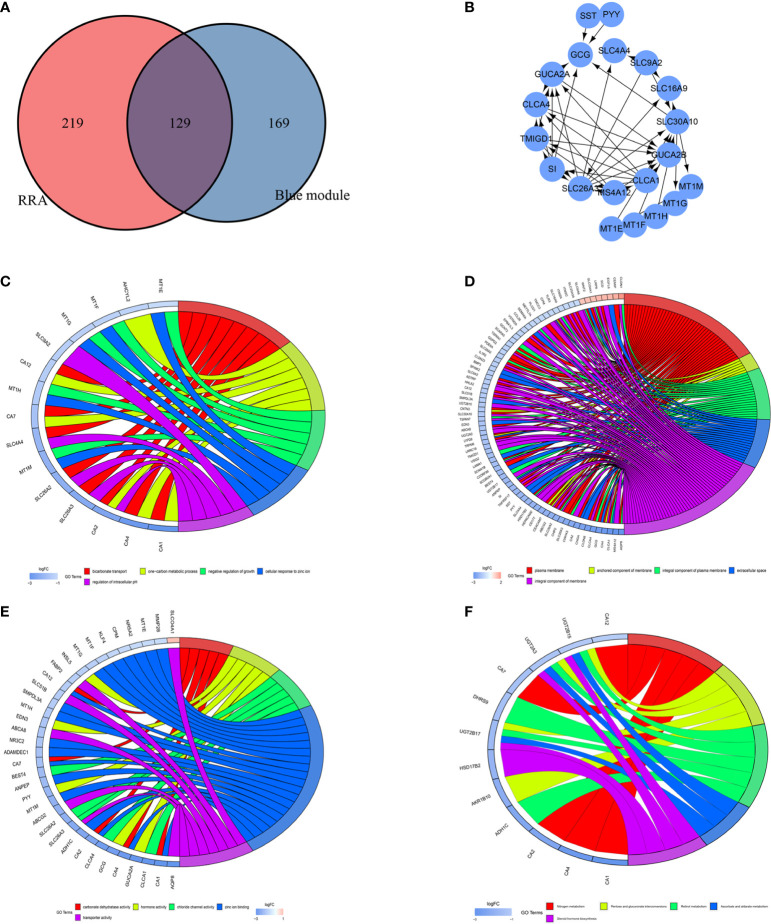
Identification of differentially expressed genes (DEGs) and hub genes. Gene ontology (GO) and Kyoto Encyclopedia of Genes and Genomes (KEGG) analyses of the DEGs. (A) Venn diagram showing the numbers of DEGs. Red indicates blue module genes in Weighted Gene Co-Expression Network Analysis (WGCNA) from the TCGA-COAD and TCGA-READ datasets. Blue indicates significantly differentially expressed genes in robust rank aggregation (RRA) analysis of Gene Expression Omnibus (GEO) datasets. (B) PPI network of 20 hub genes. (C) Chord plot depicting the relationships between the genes and GO biological process (BP) terms. (D) Chord plot depicting the relationships between the genes and GO cellular component (CC) terms. (E) Chord plot depicting the relationships between the genes and GO molecular function (MF) terms. (F) Chord plots depicting the functions of the genes in KEGG pathways.